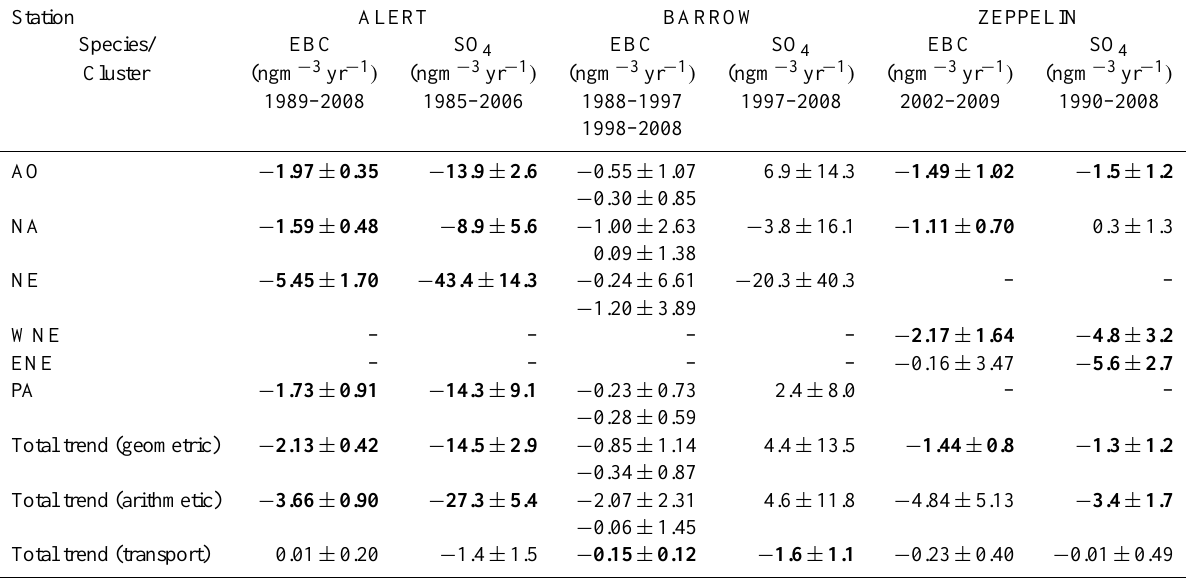
Table 3. Summary of the overall as well as cluster related yearly trends (based on geometric mean conc.) for EBC and sulphate at Alert, Barrow, and Zeppelin. Statistically significant trends at a 90% confidence level are shown in bold. Station ALERT BARROW